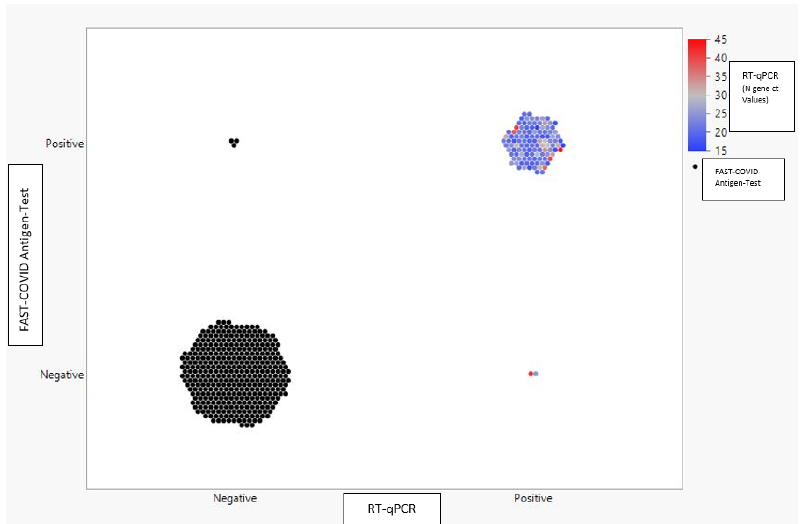
Figure 3. Comparison of RT-qPCR and antigenic test results. Graphical distribution of 501 SARS-CoV-2-positive and -negative samples detected through FAST COVID Ag-RDT respect to Ct values for the N gene resulting from RT-qPCR analysis. All colored dots are representative of SARS-CoV-2-positive samples diagnosed as described in the Materials and Methods section. Red dots represent samples with very late or no amplification of N (Ct > 40) but positive for RdRP/Hel gene amplification. Among positive samples to RT-qPCR test, 36 (31.30%) showed mean Ct values for the analyzed viral genes ≤ 20, 66 (57.39%) showed a mean Ct > 20 and ≤ 30, and 13 (11.30%) had a mean Ct value ≥ 30 and <40, indicating that, using Ct values as a proxy of viral load, more than half of the positives identified have a high (mean Ct ≤ 20) or medium-high (20 > Ct ≥ 30) viral load. Interestingly, one false negative sample showed medium Ct values (N: 25; E: 24; RdRp/Hel: 25; mean CT values: 24.67) and the other had high Ct